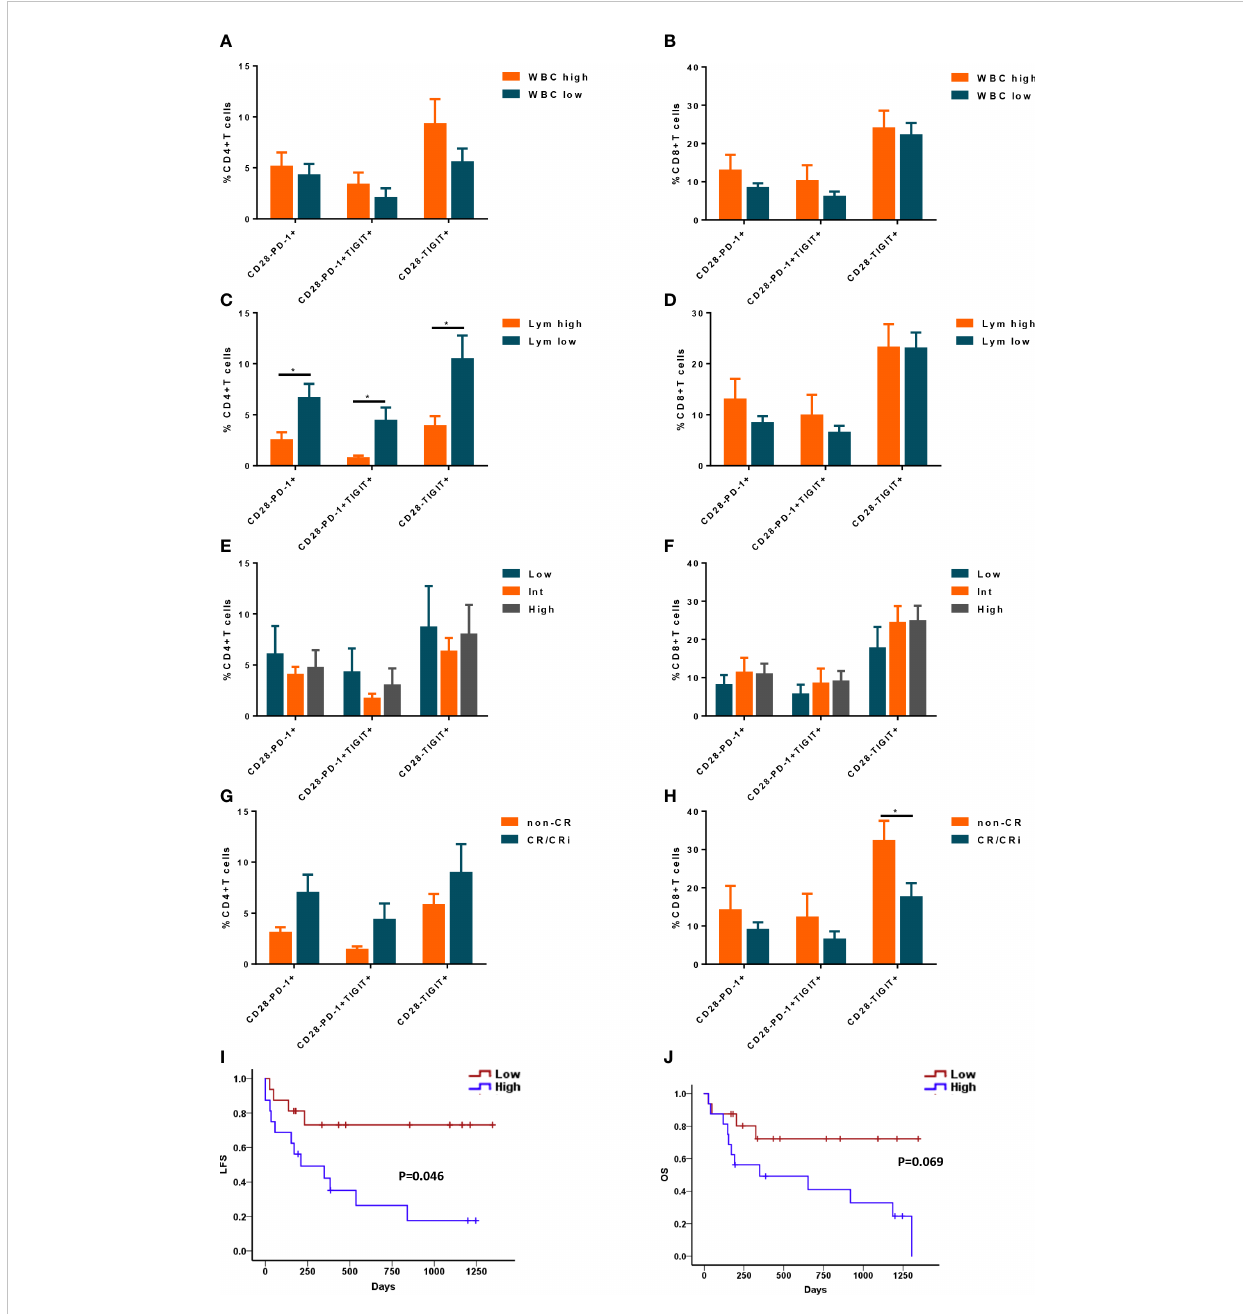
FIGURE 6 The correlation between CD28 - exhausted subsets and clinical features and outcome of AML patients. The percentages of CD28 - PD-1 + , CD28 - PD- 1 + TIGIT + , and CD28 - TIGIT + subsets in CD4 + T cells (A) and CD8 + T cells (B) in BM were analyzed in AML patients with low and high level of white blood cell count (WBC) (n=22 and 20 respectively). Likewise, the percentages of CD28 - PD-1 + , CD28 - PD-1 + TIGIT + , and CD28 - TIGIT + subsets in CD4 + T cells (C) and CD8 + T cells (D) in BM were analyzed in AML patients with low(n=22) and high level of lymphocyte count (n= 20 respectively). Moreover, the percentages of CD28 - PD-1 + , CD28 - PD-1 + TIGIT + , and CD28 - TIGIT + subsets in CD4 + T cells (E) and CD8 + T cells (F) in BM were analyzed in AML patients with low (n=9), intermediate(n=20) and high (n=13) cytogenetic risk. Additionally, the correlation between CD28 - PD-1 + , CD28 - PD-1 + TIGIT + , and CD28 - TIGIT + subsets in CD4 + T cells (G) and CD8 + T cells (H) in BM and treatment response were evaluated